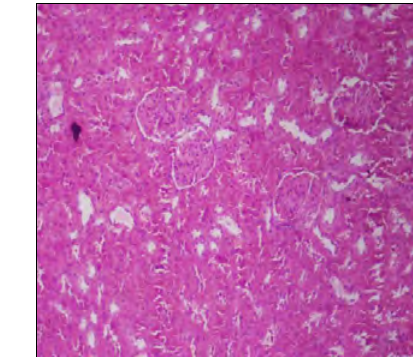
Figure-6. Photomicrograph of kidney showing mild degenerative changes. H&E X200 (Group 8)